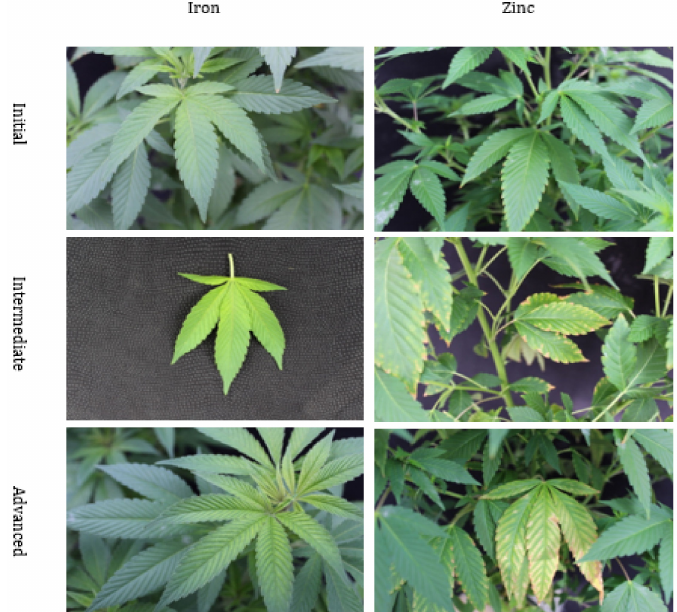
Figure 6. Nutritional disorders of iron (Fe) and zinc (Zn) deficiencies in Cannabis sativa ‘T1’ plants. These pictures display the symptomological progression of nutritional orders as they progress from initial, intermediate, and